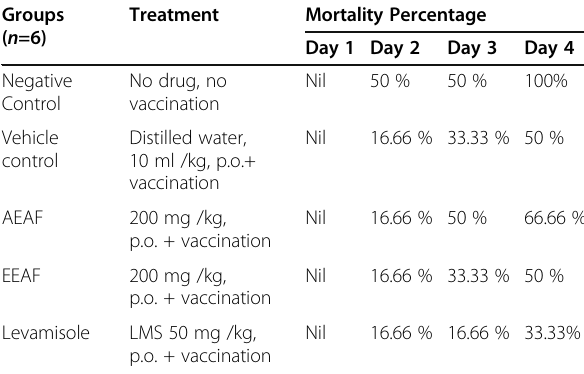
Table 11 Effect of aqueous and ethanolic extract of A. ficulneus L. leaves on Mice lethality rate in